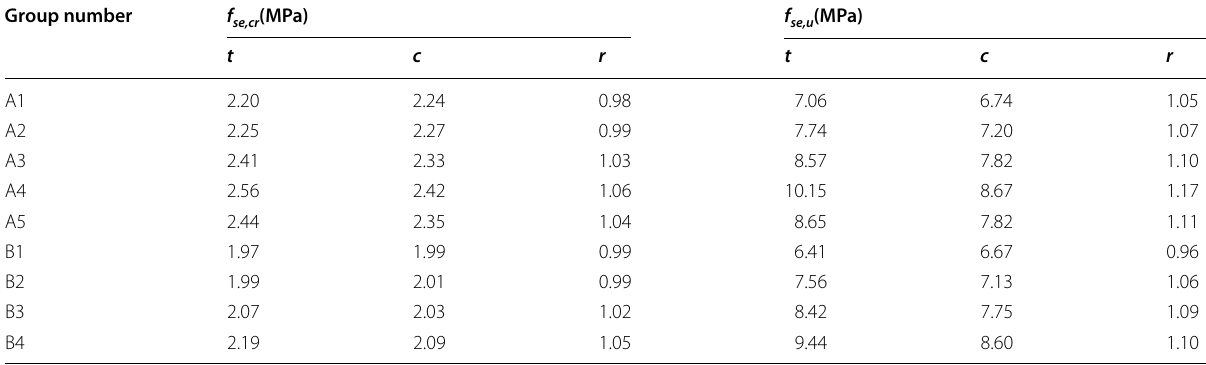
Table 7 Comparison of calculated results of cracking stress and tensile strength by using Eq. (6) and test results. Group